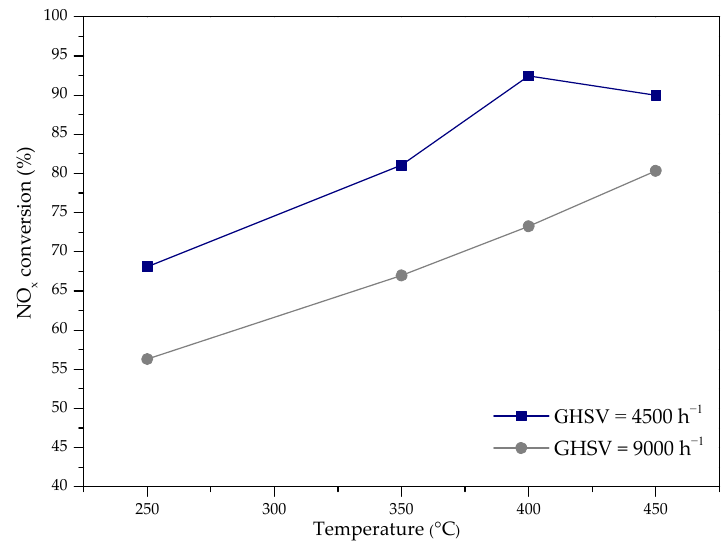
Figure 6. NO x conversion as a function of temperature and catalyst load for H-Clin.